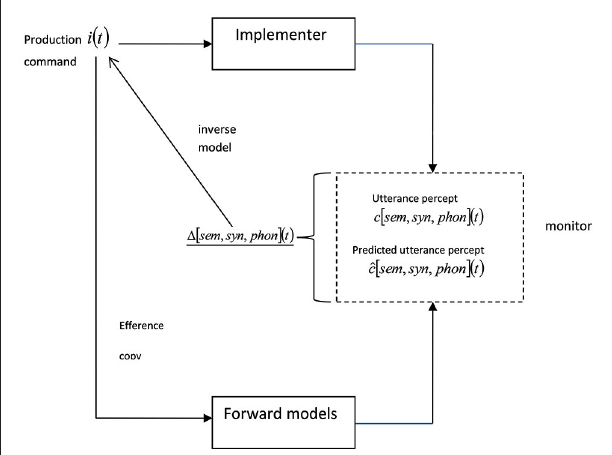
FIGURE 1 | Self-monitoring using forward models. The implementer Q3 Self-monitoring using forward models. The implementer uses the production command to construct the utterance percept. The uses the production command to construct the utterance percept. The forward models use an efference copy of the production command to forward models use an efference copy of the production command to construct the predicted utterance percept. The monitor computes the construct the predicted utterance percept. The monitor computes the discrepancy between the utterance percept and the predicted utterance discrepancy between the utterance percept and the predicted utterance percept, which can then be used (as an inverse model) to modify the percept, which can then be used (as an inverse model) to modify the production command, or assist in the construction of a new production production command, or assist in the construction of a new production command.